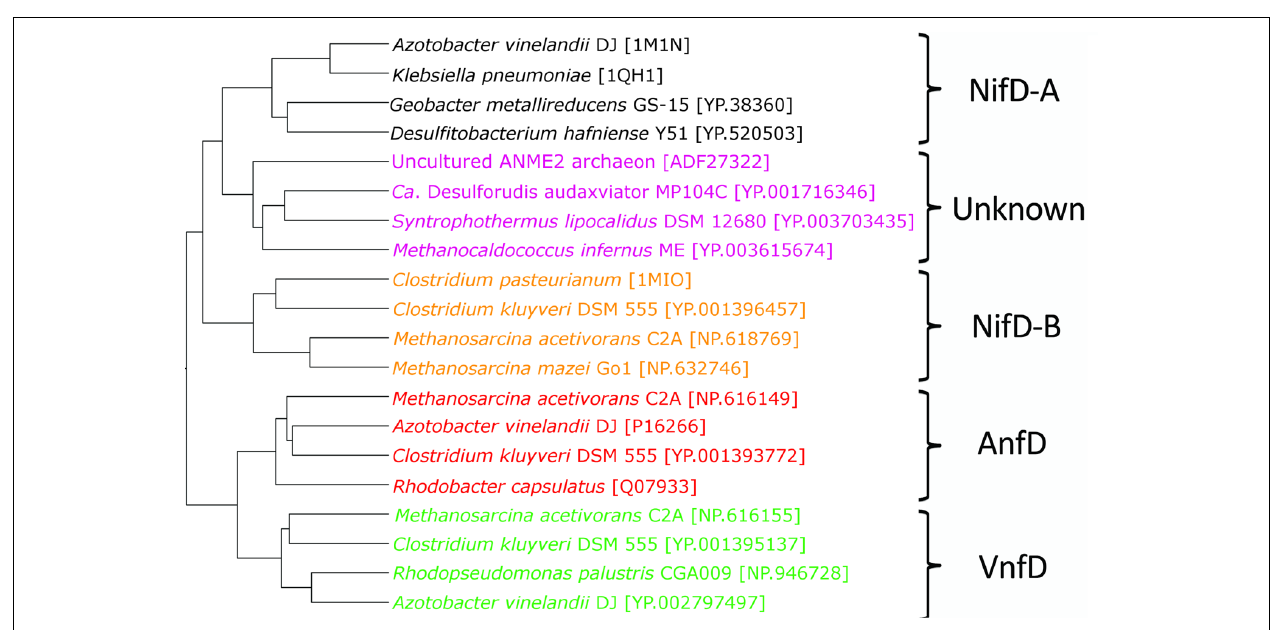
FIGURE 4 | Structural relationships among nitrogenase D subunits as calculated byVoronoi contacts and the complete linkage clustering method. NifD-A are denoted in black, NifD-B in orange, uncharacterized nitrogenases in purple, AnfD in red, andVnfD in green.